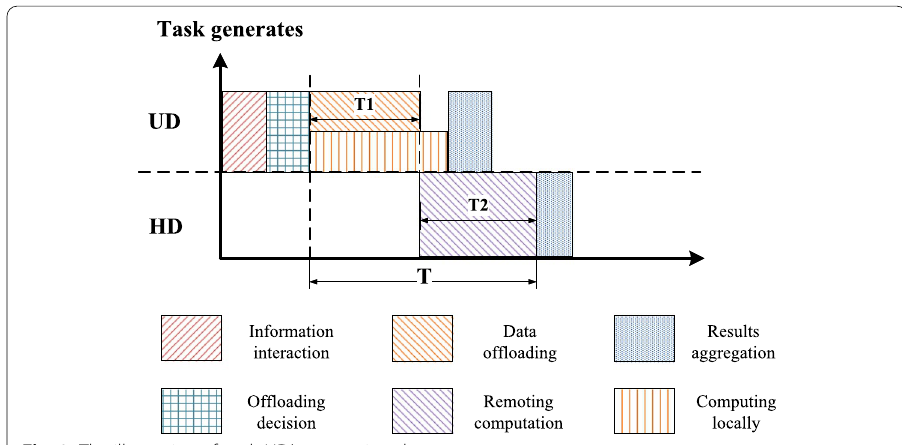
Fig. 2 The illustration of each UD’s processing